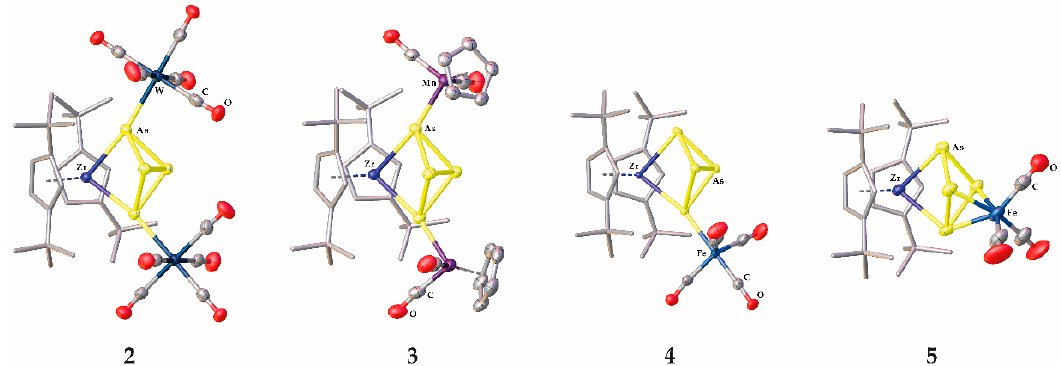
Figure 3. Molecular structures of 2 , 3 , 4 and 5 in the solid state with thermal ellipsoids at 50% probability level. Hydrogen atoms are omitted and the Cp’’ ligands are drawn in the tube model for clarity.